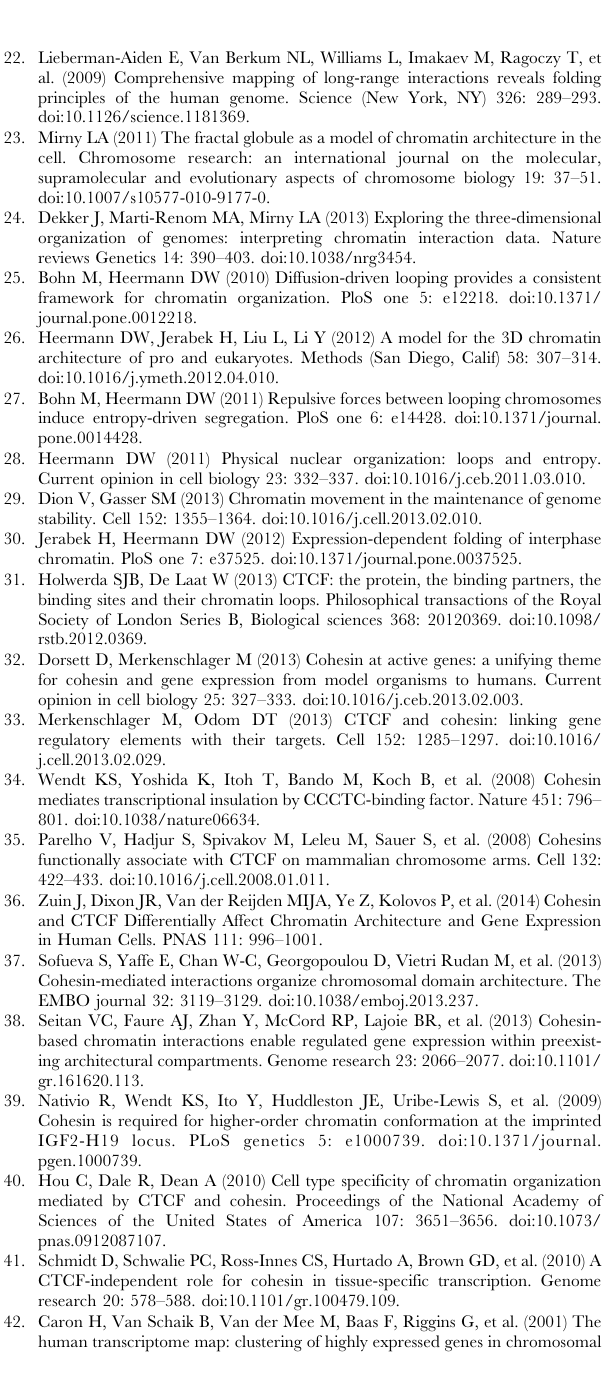
domains. Triangles below the plot indicate positions of BAC probes. Reference probes for each dataset are indicated in red. The same probes are indicated above the graph of the transcriptome map by bars (as on figure 2). Gene-rich and gene-poor genomic regions analyzed are indicated by green and red bar, respectively. Table S1 BACs used and their positions on human genome assembly 18 (Hg18). Table S2 siRNAs